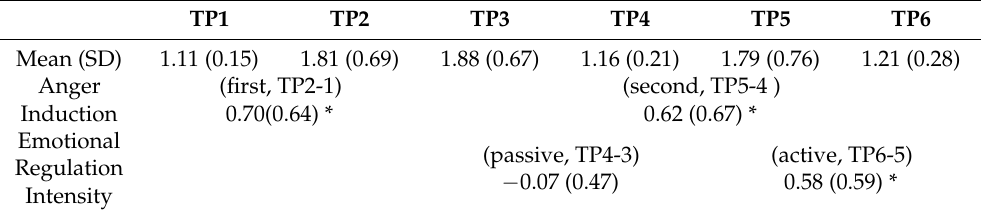
Table 3. STAXI-2 ratings (mean and standard deviation) across all time points and resulting values of anger induction and emotional regulation intensity (TP = Time Point; asterisks indicate significant differences from